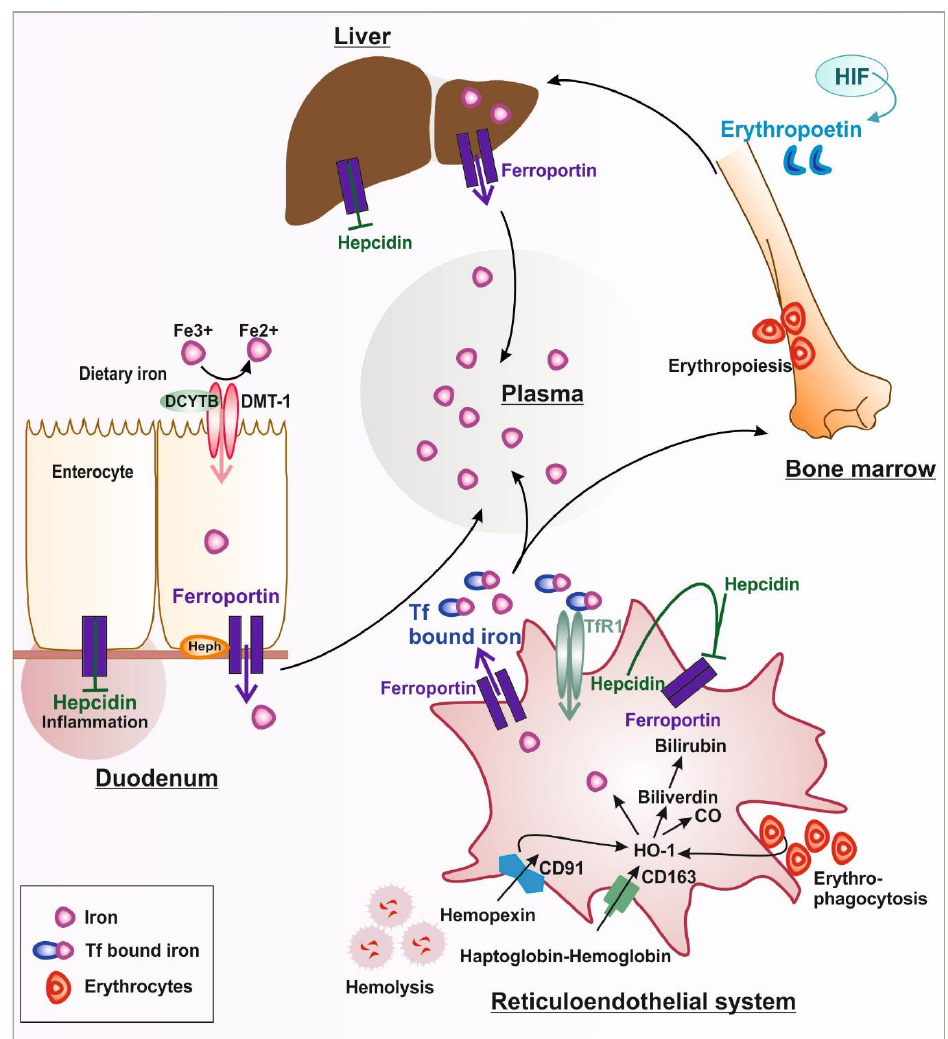
Figure 1. Main players in systemic iron metabolism.